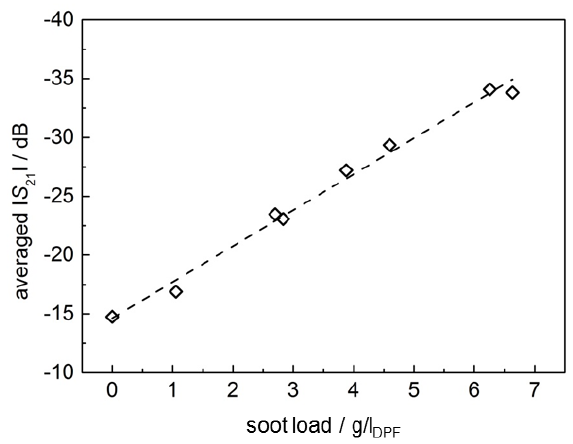
Figure 6. Correlation of the frequency-averaged transmission parameter | S 21 |and the soot load of the DPF. The dashed regression line follows the equation: | S 21 |/dB = − 3.061 · m soot /( g / l DPF ) − 14.64.